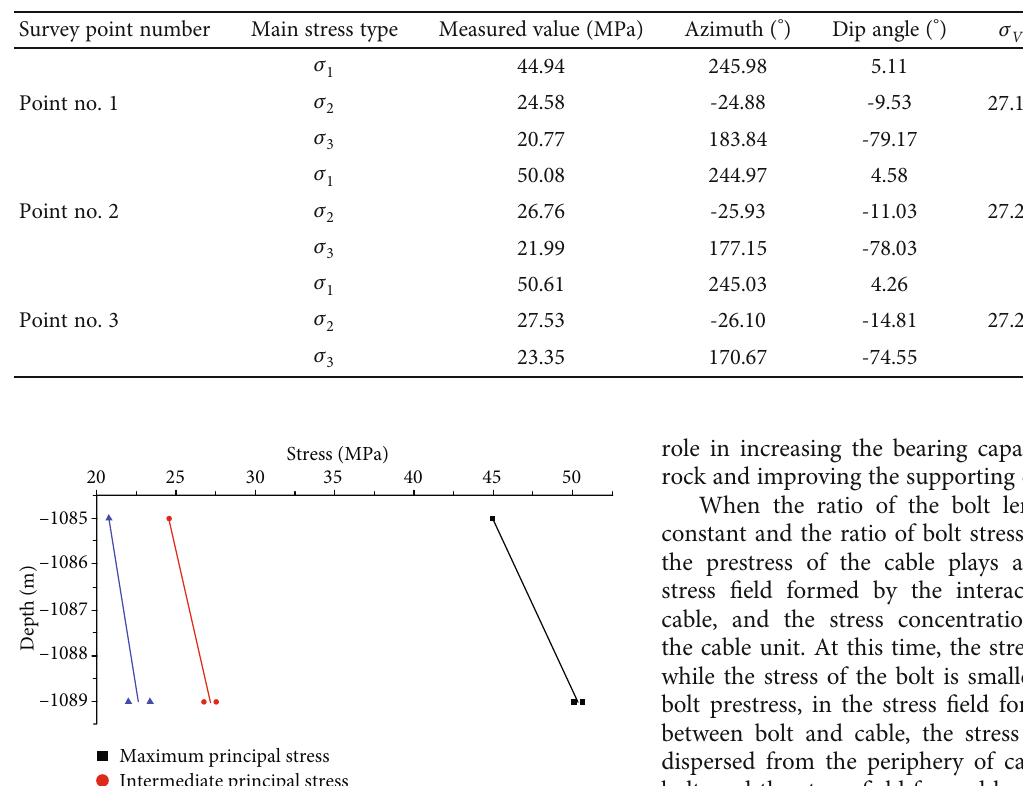
Table 3: In situ stress measurement results of each measuring point.